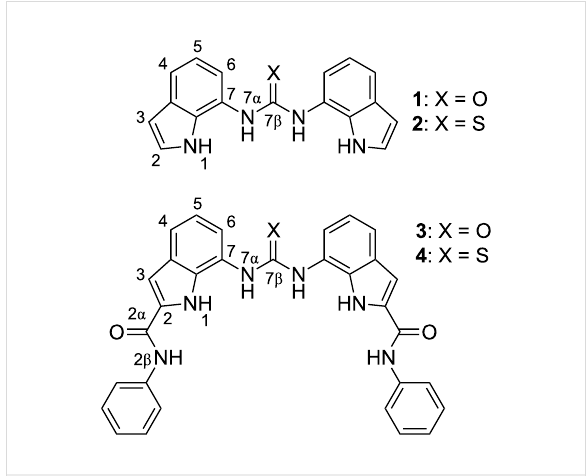
Figure 1: Anion receptors 1 – 4 together with their atomic numbering